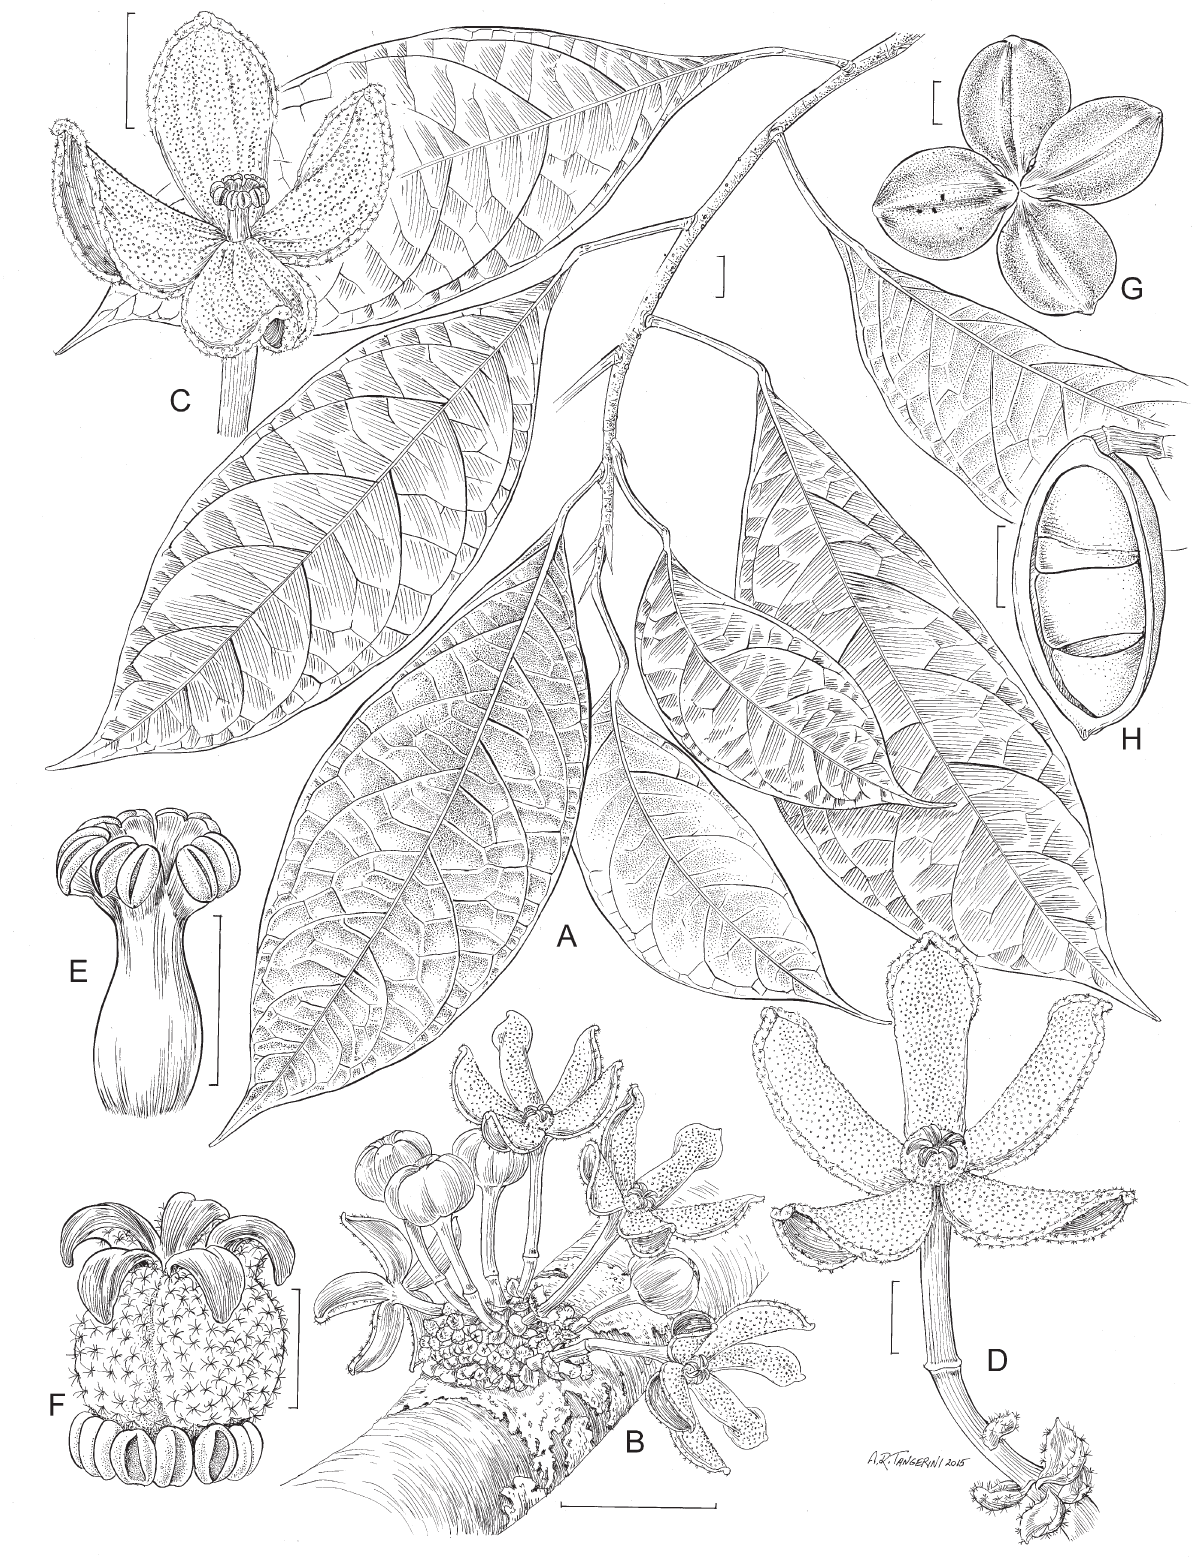
Figure 3 – Cola mamboana : A, leafy twig; B, inflorescence; C, staminate flower; D, carpellate flower; E, androgynophore; F, gynoecium; G, fruit; H, opened fruit. Scale bars: A, B, G & H = 1 cm; C & D = 2 mm; E & F = 1 mm. Drawn by Alice Tangerini. A–C & E from Sainge 1869; D & F from Kenfack 578; G & H from Sainge